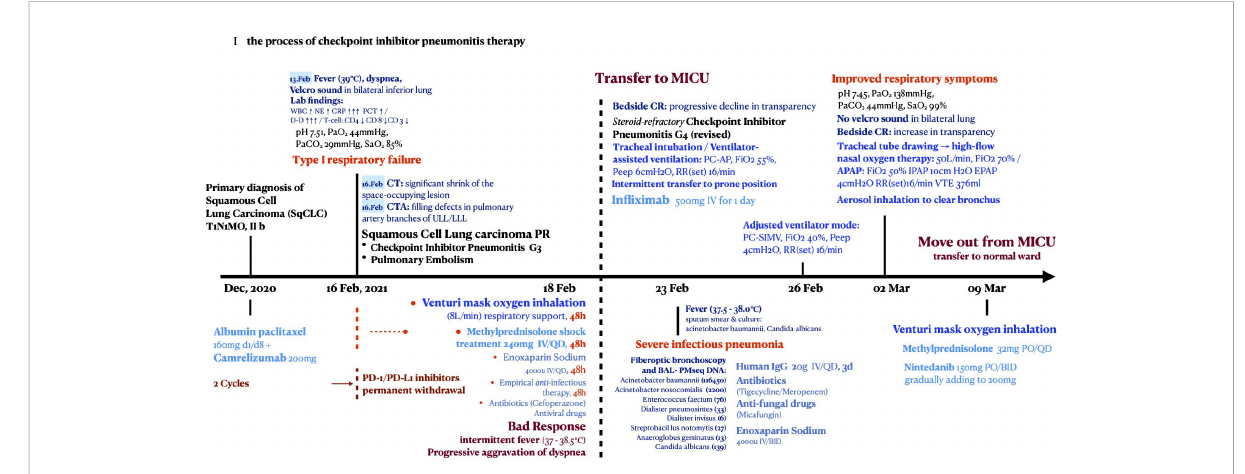
FIGURE 5 The management axis of acute severe steroid-refractory CIP.